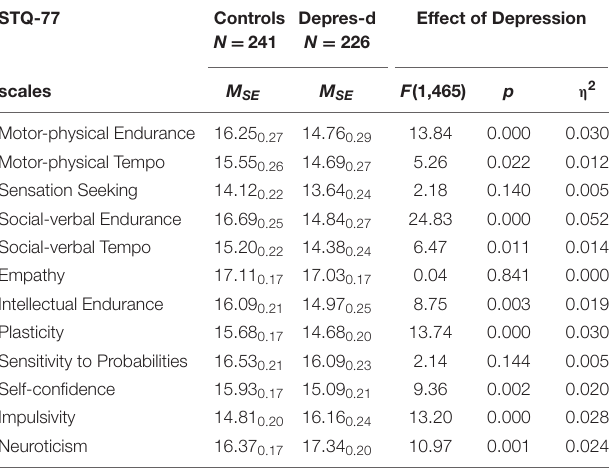
TABLE 2 | Means and Standard Error ( M SE ) on the Structure of Temperament Questionnaire (STQ)-77 scales for groups contrasted by depression (all ages combined), and the ANOVA effects. STQ-77 Controls Depres-d N = 241 N =